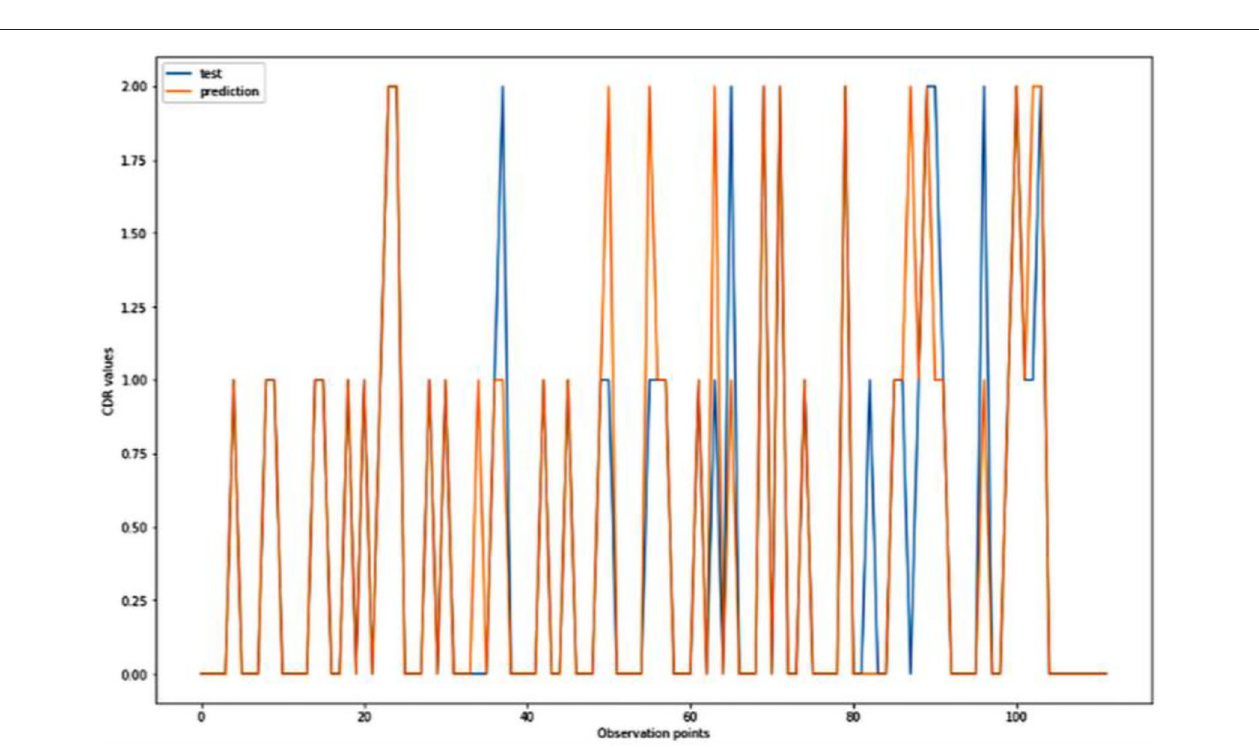
Frontiers in Public Health |